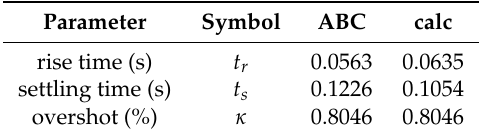
Figure 8. Step response for coefficients of SFC: ( a ) obtained by the ABC algorithm; ( b ) calculated analytically. From top: angular speed of the motor’s shaft and the system output, electromagnetic torque generated by the motor and torsional torque (experimental case). Table 6. Values of step-response indicators obtained by the ABC algorithm and calculated analytically (calc) for step change of reference signal (experimental